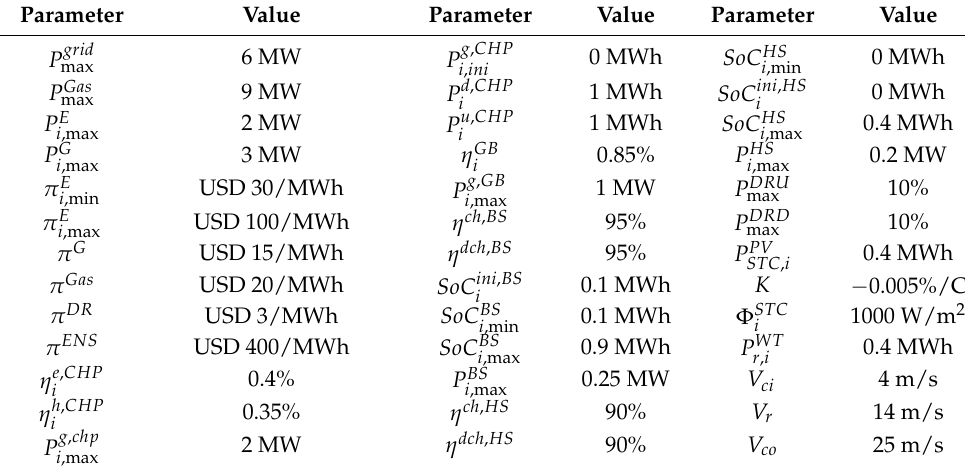
Table 1. Parameters of the proposed system.